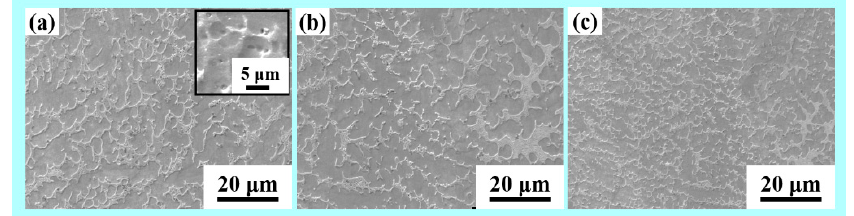
Figure 5. SEM morphology of WAAM samples ( a ) with 20 s (inset: higher magnification image), ( b ) 40 s and ( c ) 80 s interlayer delay.